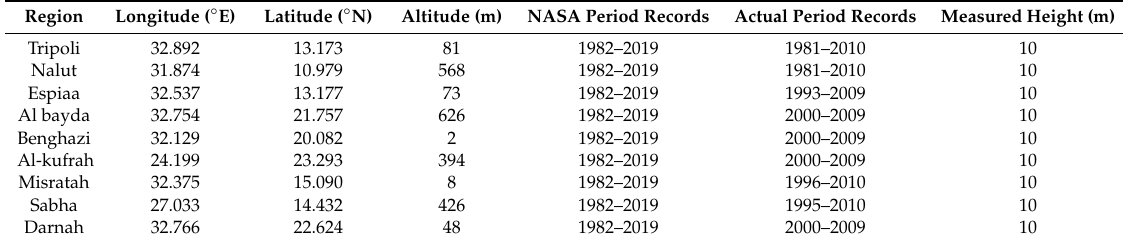
Table 1. Information for the selected